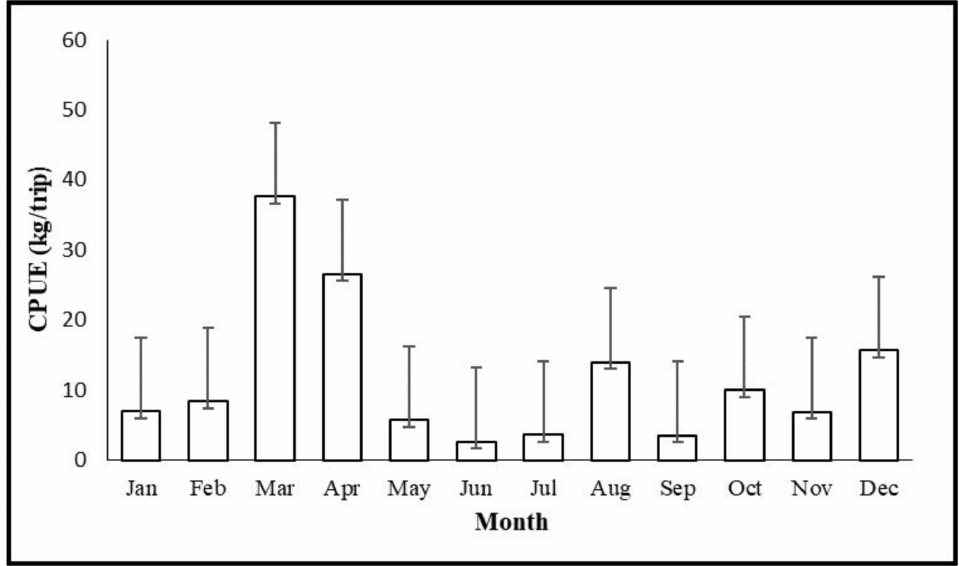
Figure 7. Littletuna( Euthynnusaffinis )monthlyCPUEchartin2020.